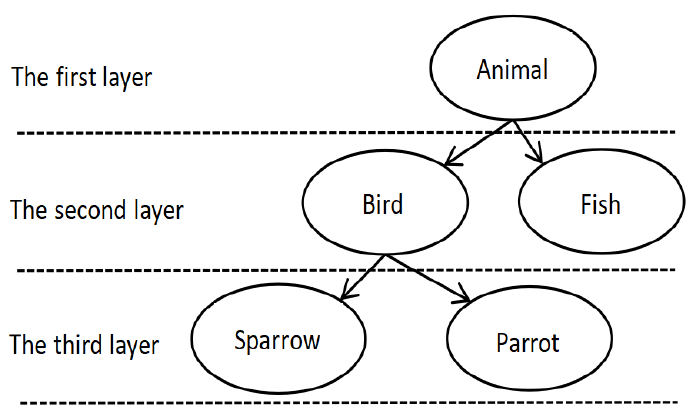
Figure 4. Depth position